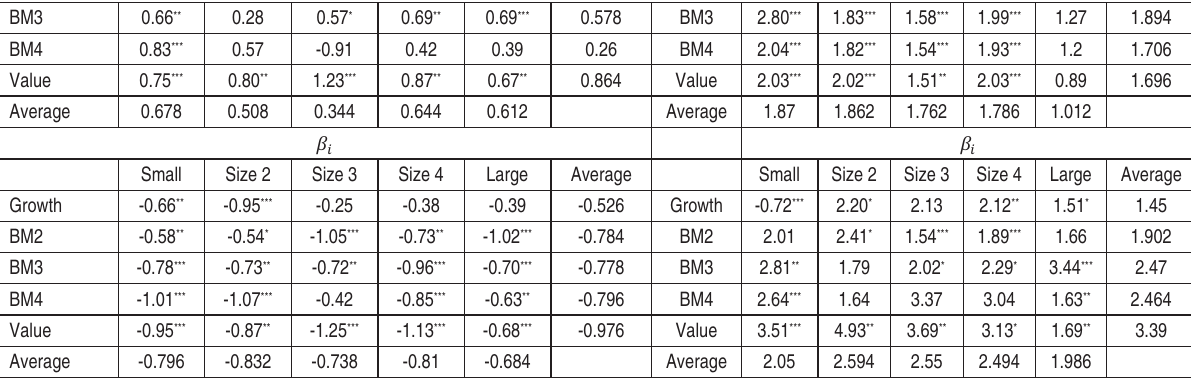
Table 5. (cont.). The impact of structural monetary policy shocks on the ERP of the 25 value-weighted Fa- ma-French portfolios: pre and post quantitative easing